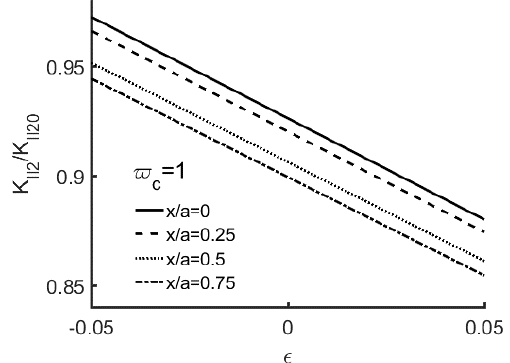
Figure 5. 𝐾 𝐼𝐼2 /𝐾 𝐼𝐼20 versus 𝜀 with 𝜛 𝑐 = 1 and 𝑥/𝑎 = 0,0. 25 ,0.5,0. 75 . Figures 6 – 8 show G 2 is increasing as remote tensile stress is rising for the case of 𝜛 𝑐 = 0 and 𝜀 = 0.01. When the relative proportion of thermal loading is especially dominant over remote tensile stress, G 2 is not positive, implying the crack is partly enclosed. The positive energy release rate will not be physically meaningful.